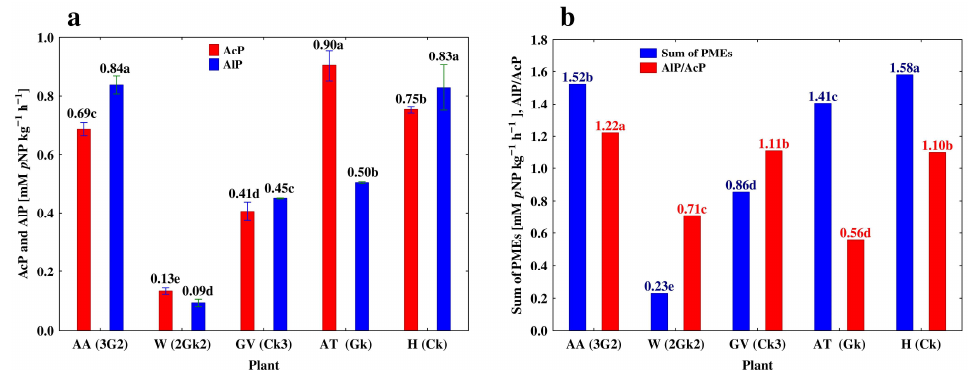
Figure 3. Effect of cultivated plants on the acid and alkaline phosphatase activity (AcP, AlP) ( a ), and sum of PMEs activities as well as the AcP/AlP ratio ( b ), in the deepest horizons (3G2, 2Gk2, Ck3, Gk, Ck). PMEs—the sum of phosphomonoesterases (AcP and AlP). AA—alfalfa, W—winter wheat, GV—grapevine, AT—apple trees, H—hop. Values for each property marked with different letters are statistically different at p < 0.05. Abbreviations of soil horizon names are explained under Table 1.